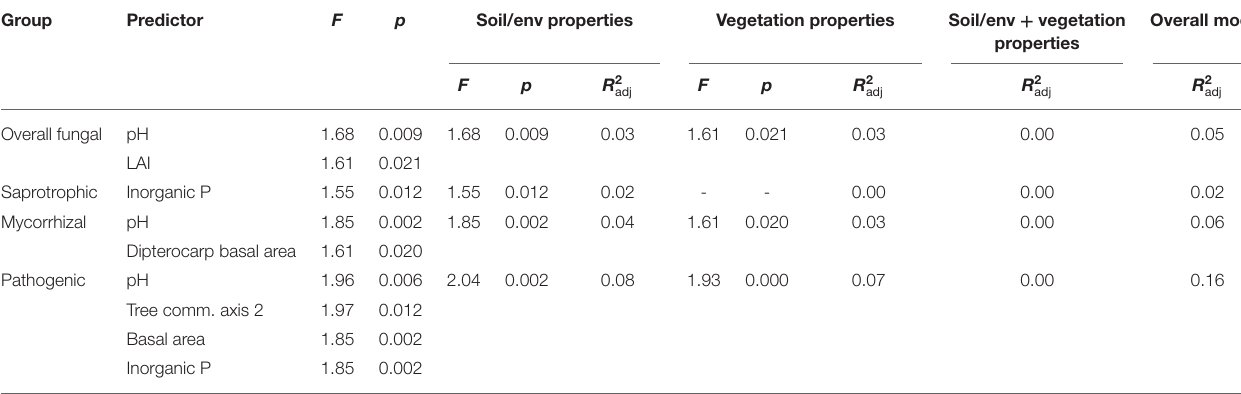
TABLE 5 | Best soil, environmental and vegetation characteristics as predictors of fungal group dissimilarities across old-growth and selectively logged lowland dipterocarp rainforest in Sabah, Borneo, identified by forward selection (adjusted R 2 and p > 0.05) in distance-based redundancy analysis (db-RDA). Group